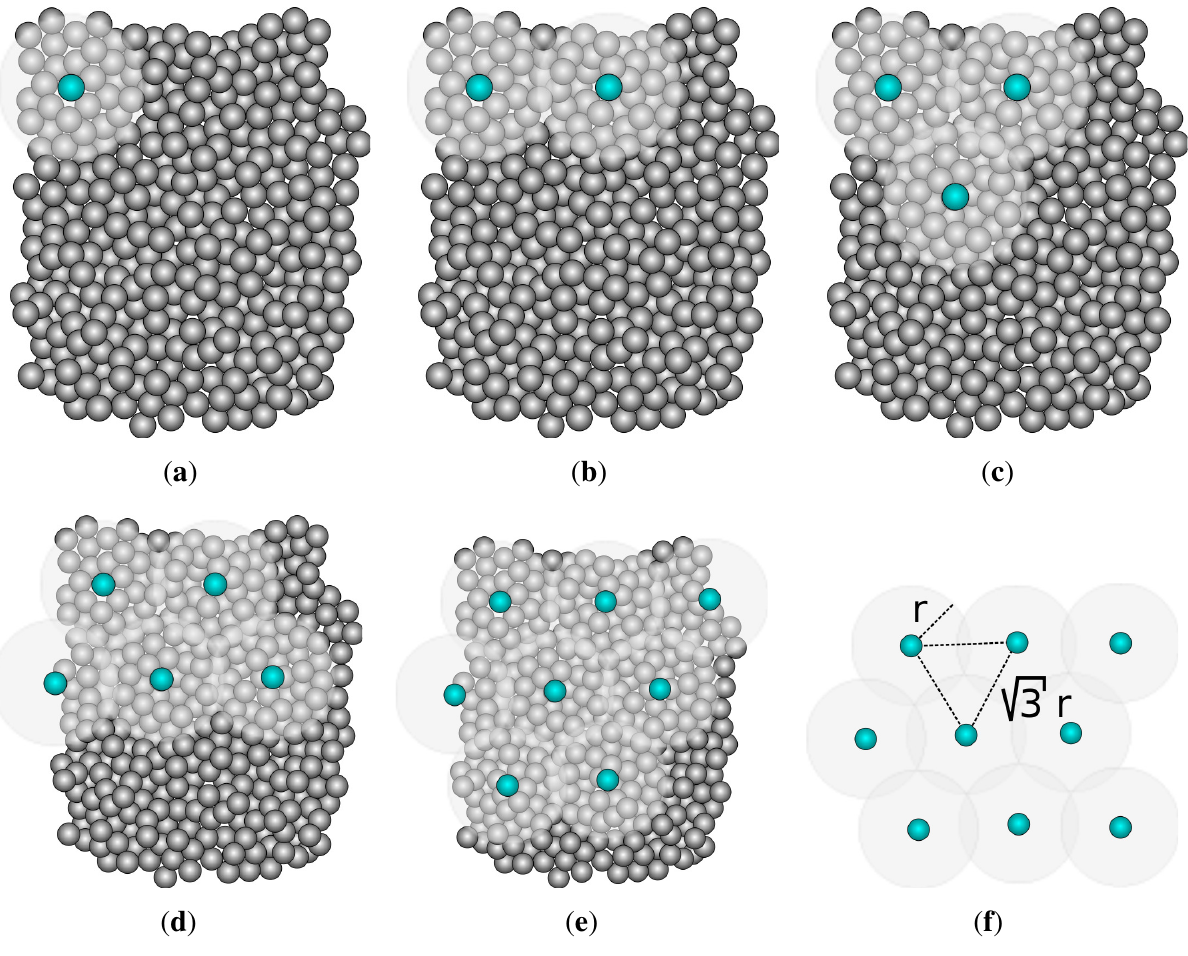
Figure 3. Overview of OGDC . ( a ) Algorithm starts; ( b ) Neighbor in random direction; ( c ) Equilateral triangle; ( d ) Process repeats; ( e ) Nodes cover sensing area; ( f ) Algorithm completed.